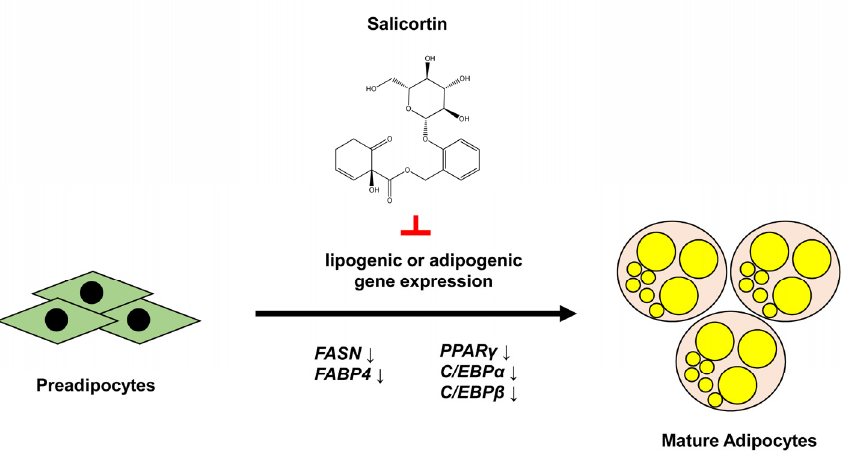
Figure 5. Model of mechanism of salicortin’s action. Salicortin suppresses adipocyte differentiation by reducing the mRNA and protein levels of lipogenic and adipogenic factors.